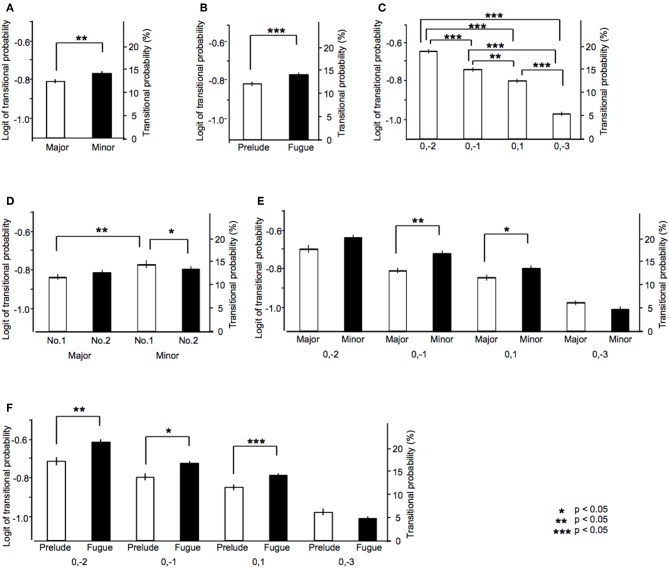
The results of ANOVA in analysis 2. The main effects of (A) tonality, (B) type, and (C) sequence. The interactions of (D) tonality-number, (E) tonality-sequence, and (F) type-sequence.